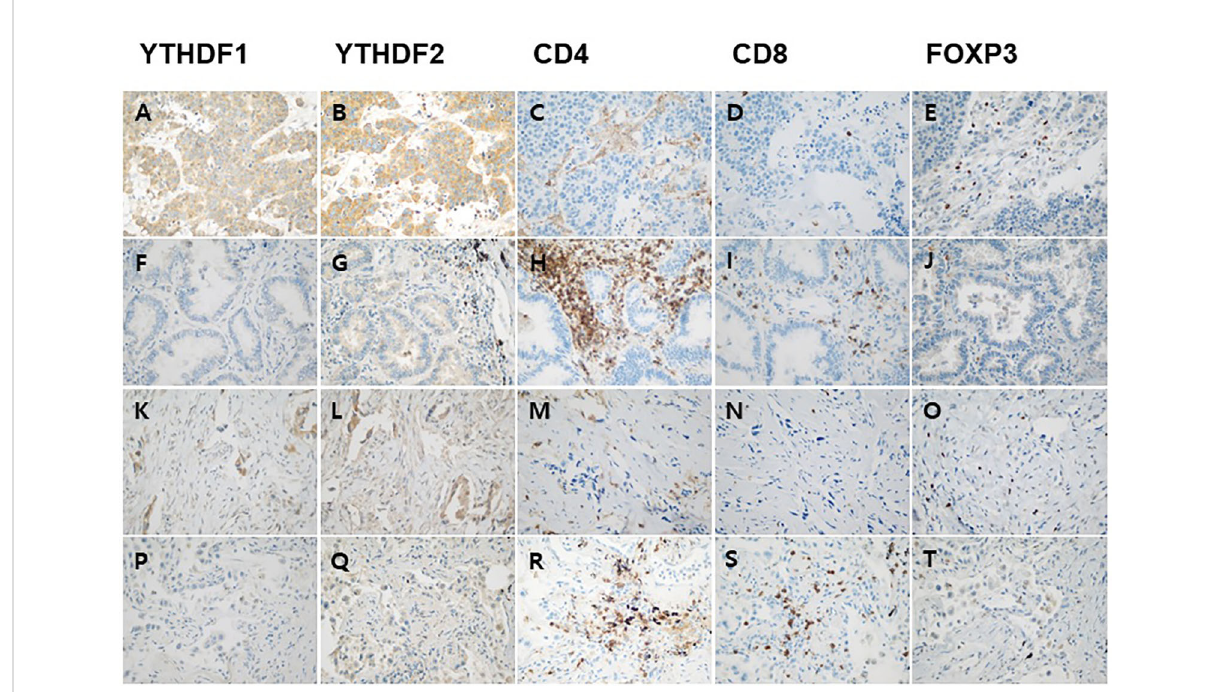
FIGURE 3 Representative immunohistochemical images of YTHDF1, YTHDF2, CD4, CD8, and FOXP3 expression in adenocarcinoma. High YTHDF1 (A) or YTHDF2 (B) case is associated with low CD4 (C) , CD8 (D) and high FOXP3 (E) expression in PD-1 inhibitor non-treatment group. Low YTHDF1 (F) or YTHDF2 (G) case is associated with high CD4 (H) , CD8 (I) and low FOXP3 (J) expression in PD-1 inhibitor non-treatment group. High YTHDF1 (K) or YTHDF2 (L) case is associated with low CD4 (M) , CD8 (N) and high FOXP3 (O) expression in PD-1 inhibitor treatment group. Low YTHDF1 (P) or YTHDF2 (Q) case is associated with high CD4 (R) , CD8 (S) and low FOXP3 (T) expression in PD-1 inhibitor treatment group.